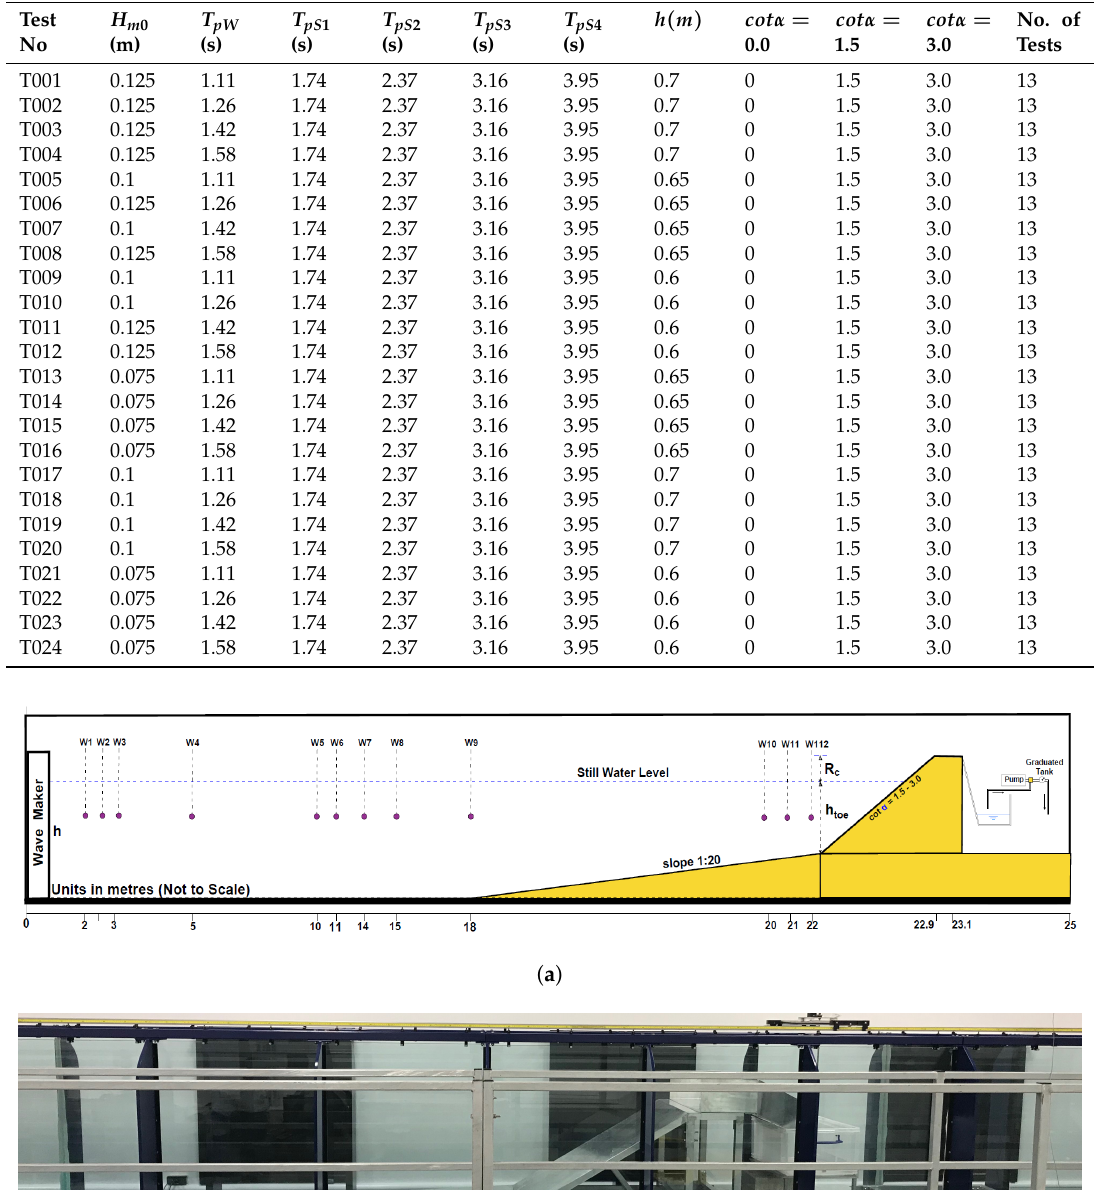
Table 1. Bimodal wave conditions with the peak period of wind waves ( T pW ) and peak periods of swell waves T pS 1 − S 4 tested in the present study.